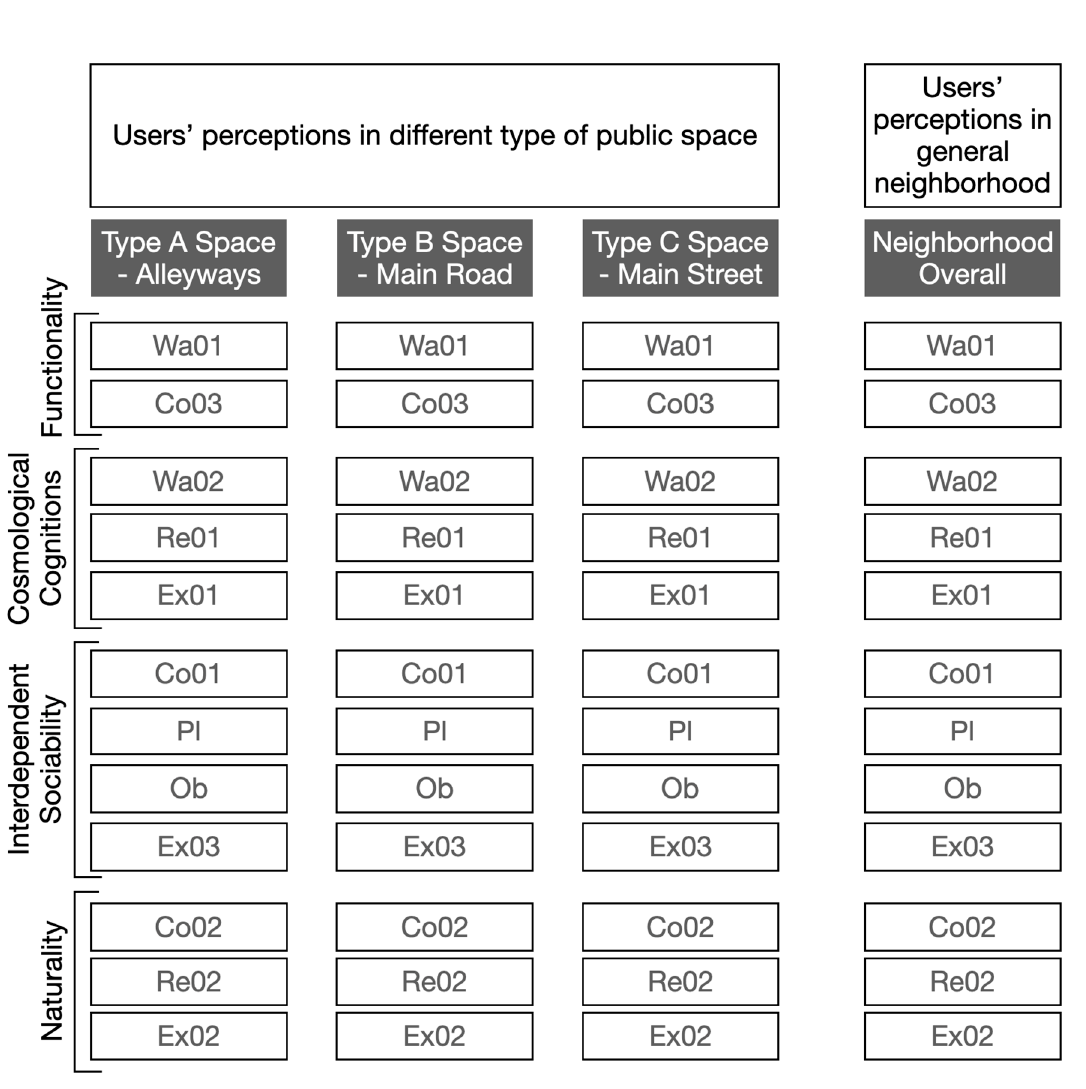
Figure 9. The structure of analysis between the type of spaces and local place qualities.